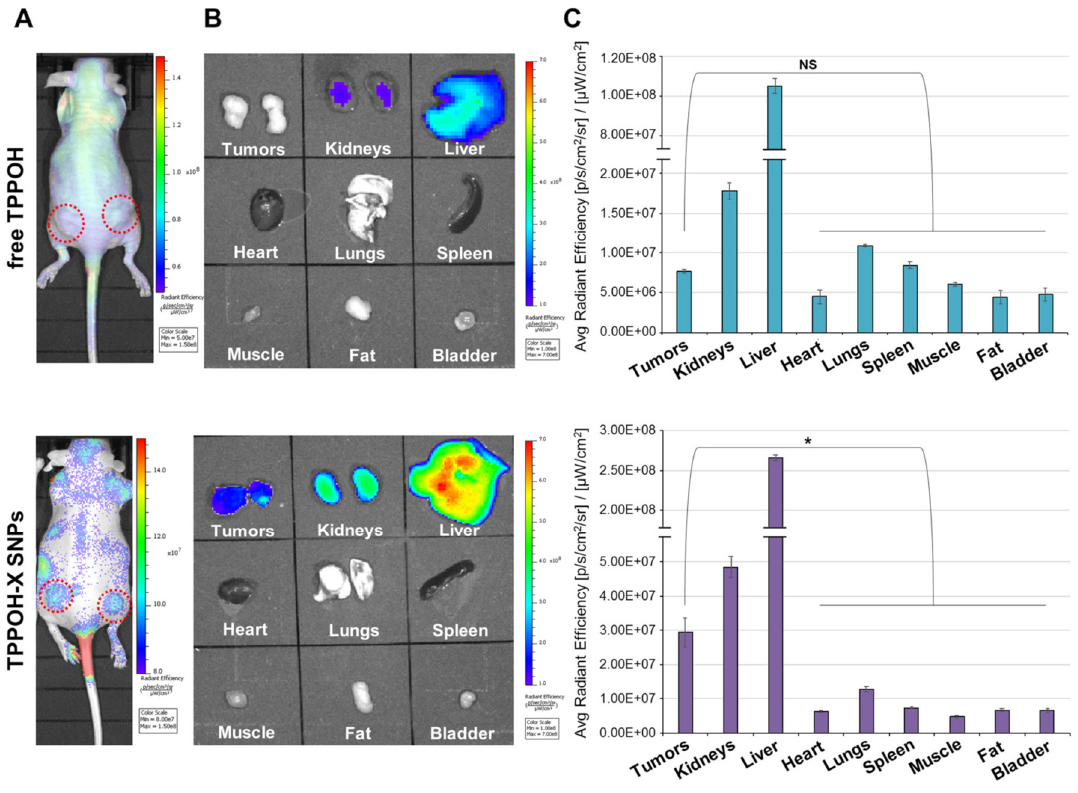
Figure 6. Evaluation of Cy5.5-labeled free TPPOH and TPPOH-X SNPs biodistribution by fluorescence imaging at 24 h post-injection. ( A ) In vivo fluorescence imaging of HT-29 tumor-bearing mice, ( B ) ex vivo fluorescence of tumors and organs, ( C ) fluorescence analysis of tumor and organs. Data are shown as mean ± SEM ( n = 3). * p < 0.05 and NS: not significant (adapted from Reference [102] with permission from MDPI. Copyright 2019, Cancers).